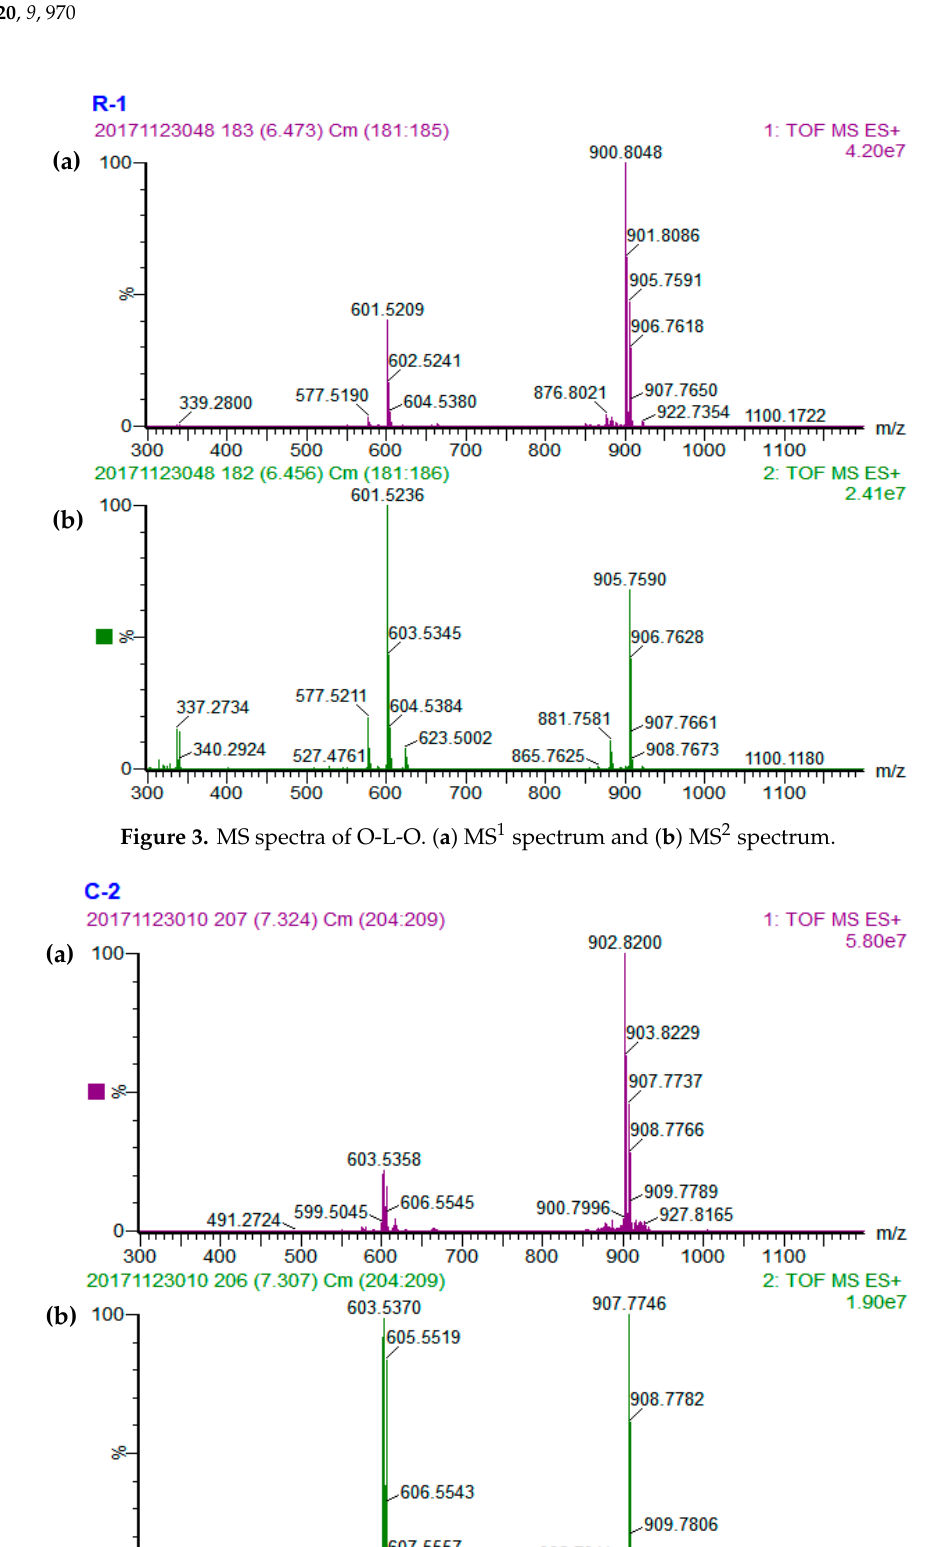
6 of 12 Figure 2. MS spectra of O-O-O. ( a ) MS 1 spectrum and ( b ) MS 2 spectrum.